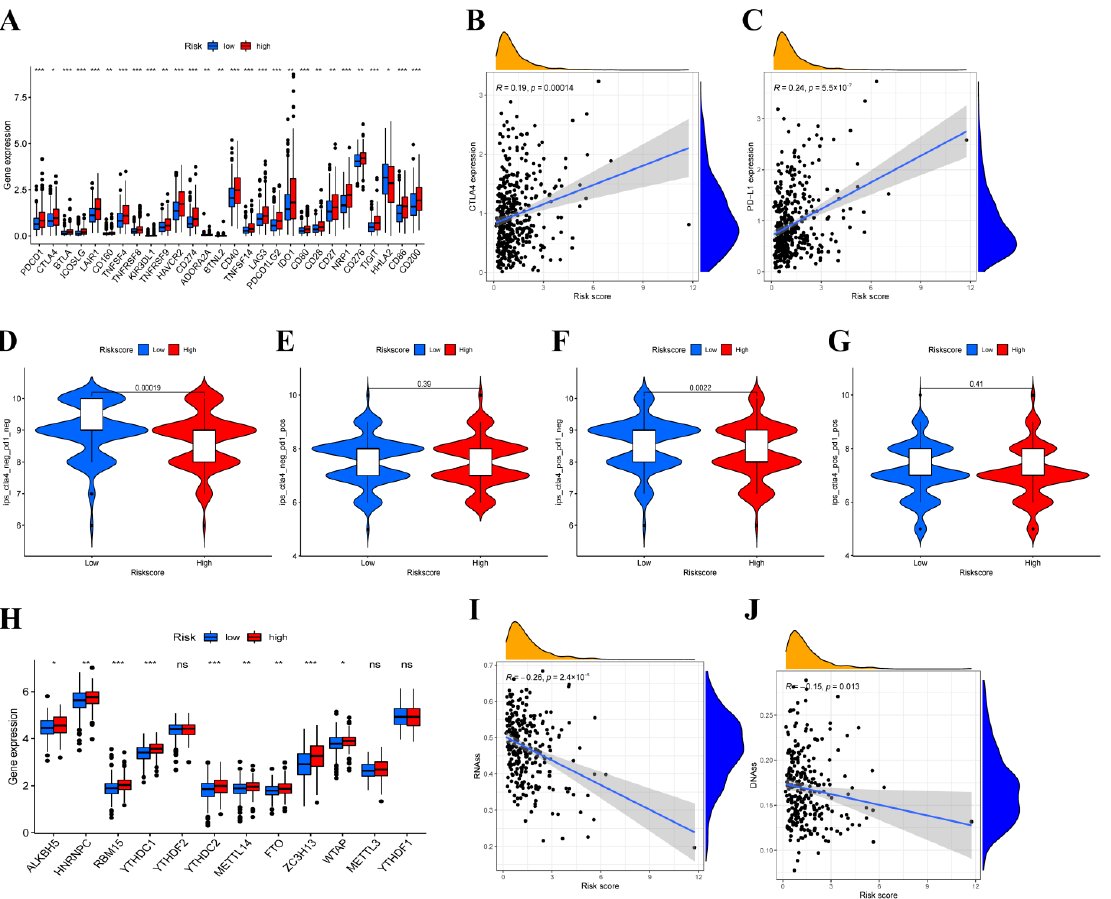
Figure 8. The results of immune checkpoint and immunophenoscore (IPS) . ( A )The expression of immune checkpoint genes and the correlation between risk score and CTLA4 expression ( B ) and PD-L1 expression ( C ). ( D – G ) The differences of IPS in patients with different risk score. ( H ) The expression level of main genes of m6A in high-risk and low-risk groups. ( I , J ) Relationship between risk score and RNAss, DNAss. Adjusted p -values were shown as ns, not significant, * p < 0.05, ** p < 0.01, *** p < 0.001.